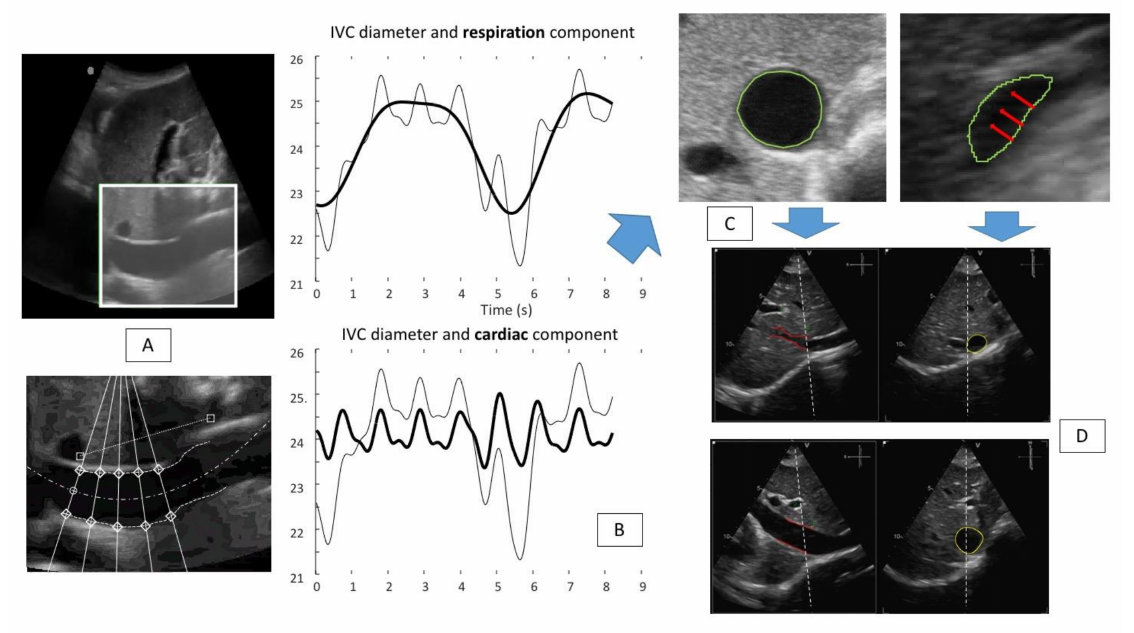
Figure 3. Panel ( A ): IVC tracking technique: the software is able to identify the vessel (IVC long axis view) ( top ) of interest and perform the edge tracking of five fixed points along both edges of the vessel ( bottom ). Panel ( B ): the results of the edge tracking techniques are shown: respiratory ( top ) and cardiac ( bottom ) components are represented. (Bold line graphic on top: respiratory component of the IVC diameter variation (mm). Bold line graphic at the bottom: cardiac component of the IVC diameter variation (mm). Non-bold line in both graphics: IVC diameter variation during two breaths). Panel ( C ): a US IVC scan in short axis view is shown; red arrows indicate the direction of the collapsibility of the vessel walls that is not directed in an antero-posterior way, rather the main direction is medio-lateral. Panel ( D ) shows a possible solution to perform a more reliable IVC study: the use of the three-dimensional x-plane echocardiography, to gain the possibility to evaluate in real-time both long and short axis views (adapted from Mesin et al. [8]).